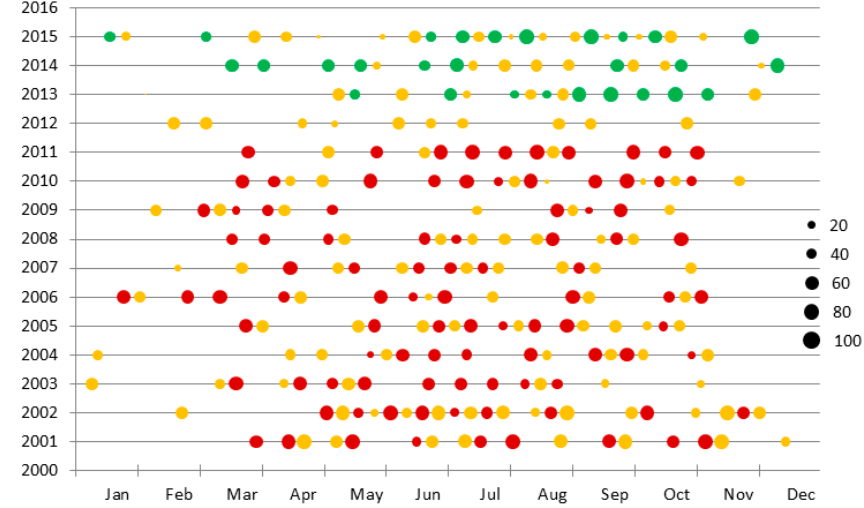
Figure 2. Landsat-5 (2001–2011, red), Landsat-7 (2001–2015, yellow), and Landsat-8 (2013–2015, green) images used in Study #1. The size of the dot represents the percentage of valid and clear pixels from the Landsat images.